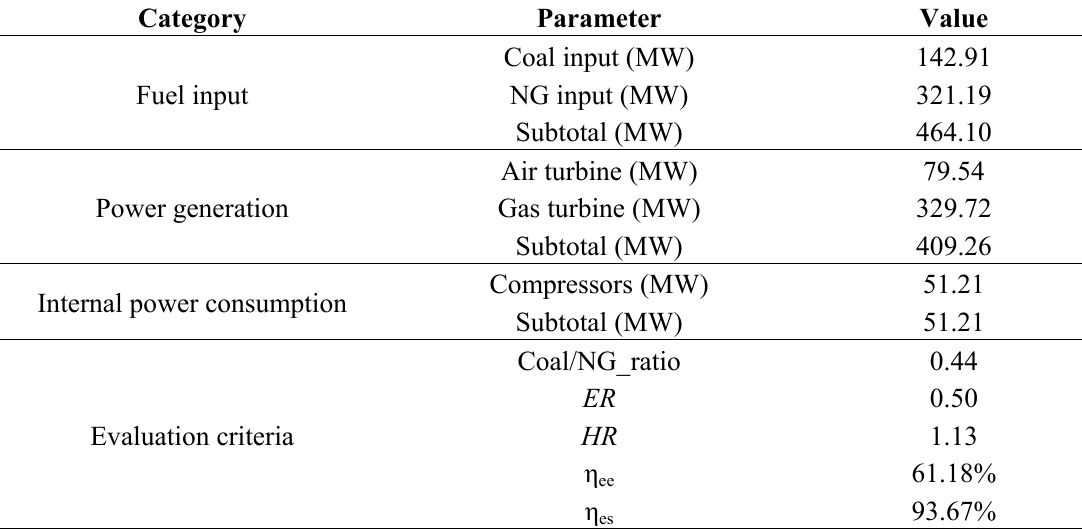
Table 3. Simulation results of the hybrid-fuel CAES system. ER : energy rate; and HR : heat rate.